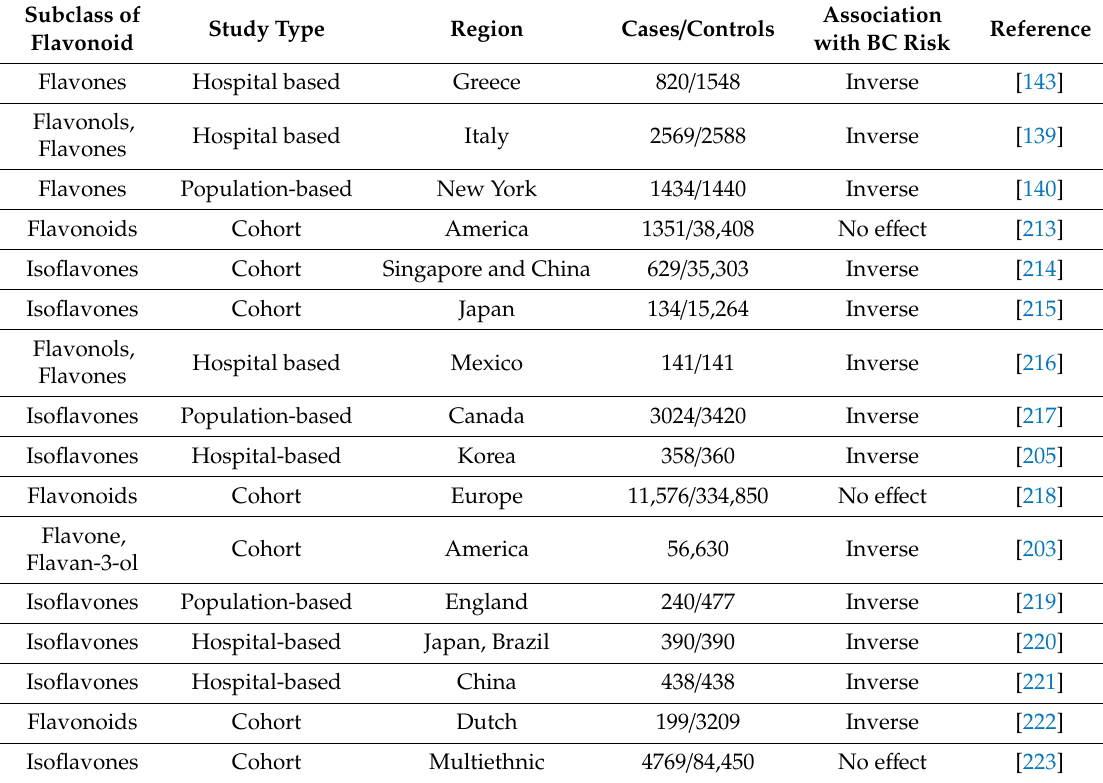
Table 3. Epidemiological prospective cohort and case control studies on dietary intake of flavonoids and breast cancer risk.